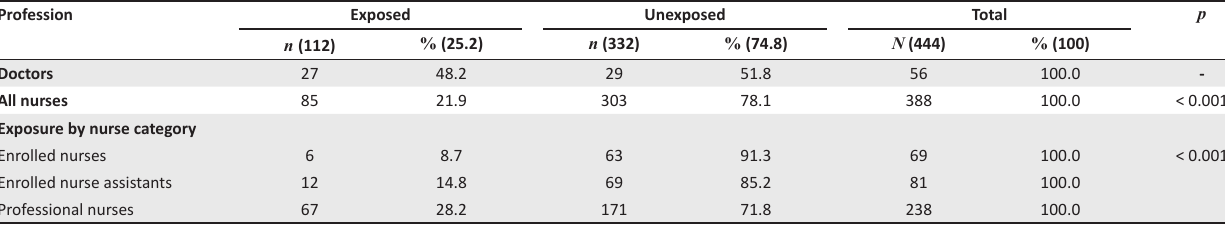
TABLE 2: Frequency of blood and body fluids exposures by professional